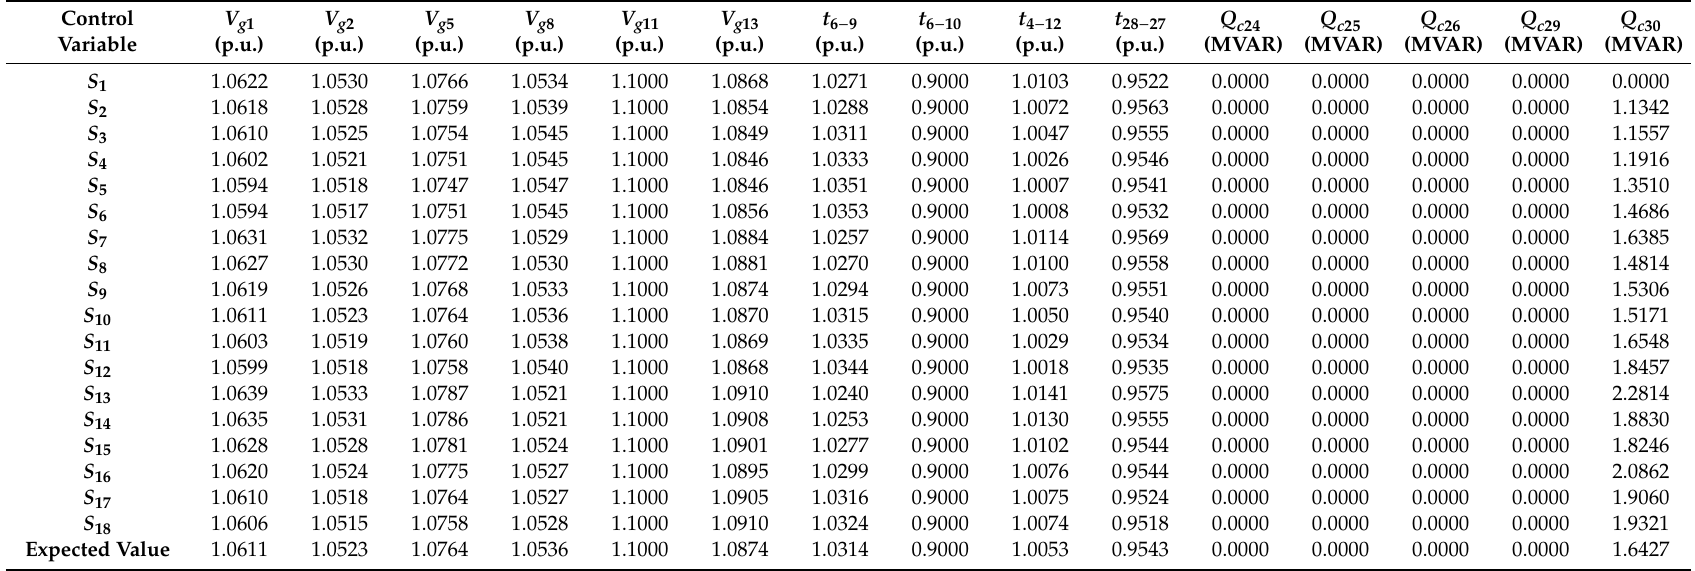
Table 17. The optimal values of the control variables for probabilistic multi-objective RPP considering load demand and wind power generation uncertainties.